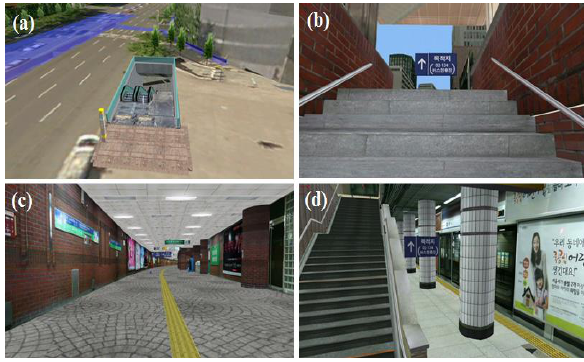
Figure 11. Mash-up Application Cases (1)